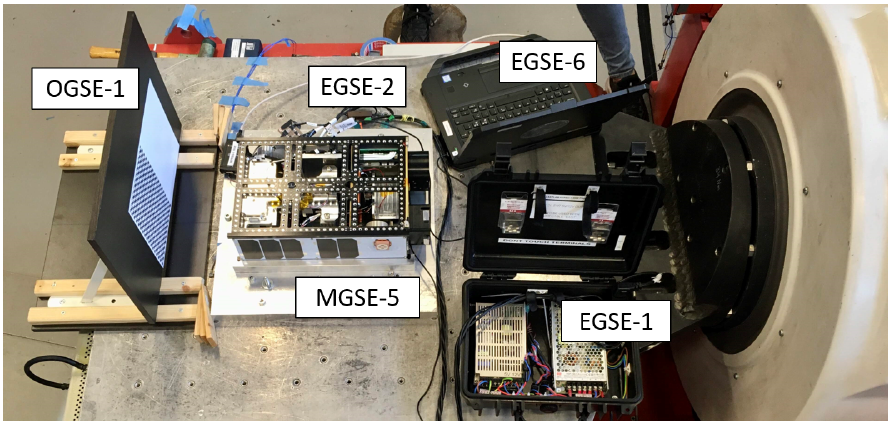
Figure 12. Portable validation setup showcasing GSE. The ”dark room” box and light source that cover the setup are not shown, but are used in this setup. OGSE-1 optical target (half white for the HSI, half checkerboard for the RGB), MGSE-5 vibration table mounting plate (clamps not shown), EGSE-6 laptop with test software, EGSE-2 testing umbilical, and EGSE-1 external power supply